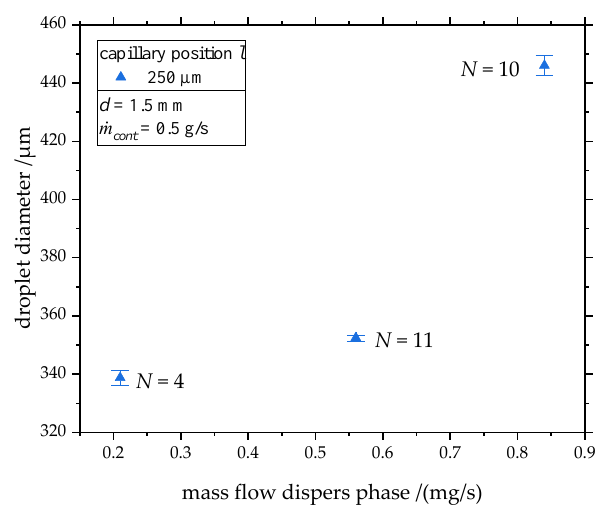
Figure 7. Droplet diameter as a function of the mass flow of the disperse phase. The diameter of the orifice was 1.5 mm and the tip of the capillary was positioned at a distance of 250 µm from the orifice exit. The mass flow of the continuous phase was set constant to 𝑚̇ 𝑐𝑜𝑛𝑡 = 0.5 g/s . N represents the number of droplets that were found in the set of 100 images.